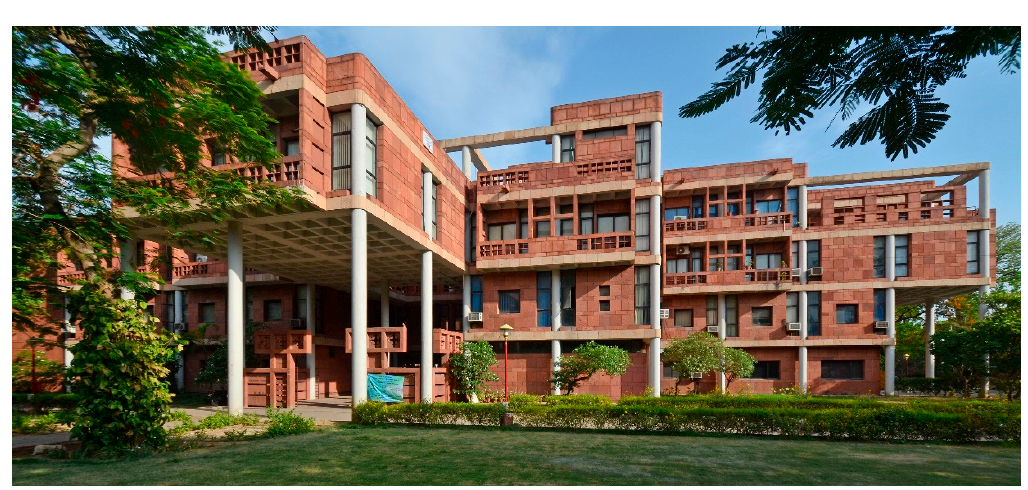
Figure 7. Central Institute of Educational Technology, New Delhi (1988) by Raj Rewal (Photo: Author).